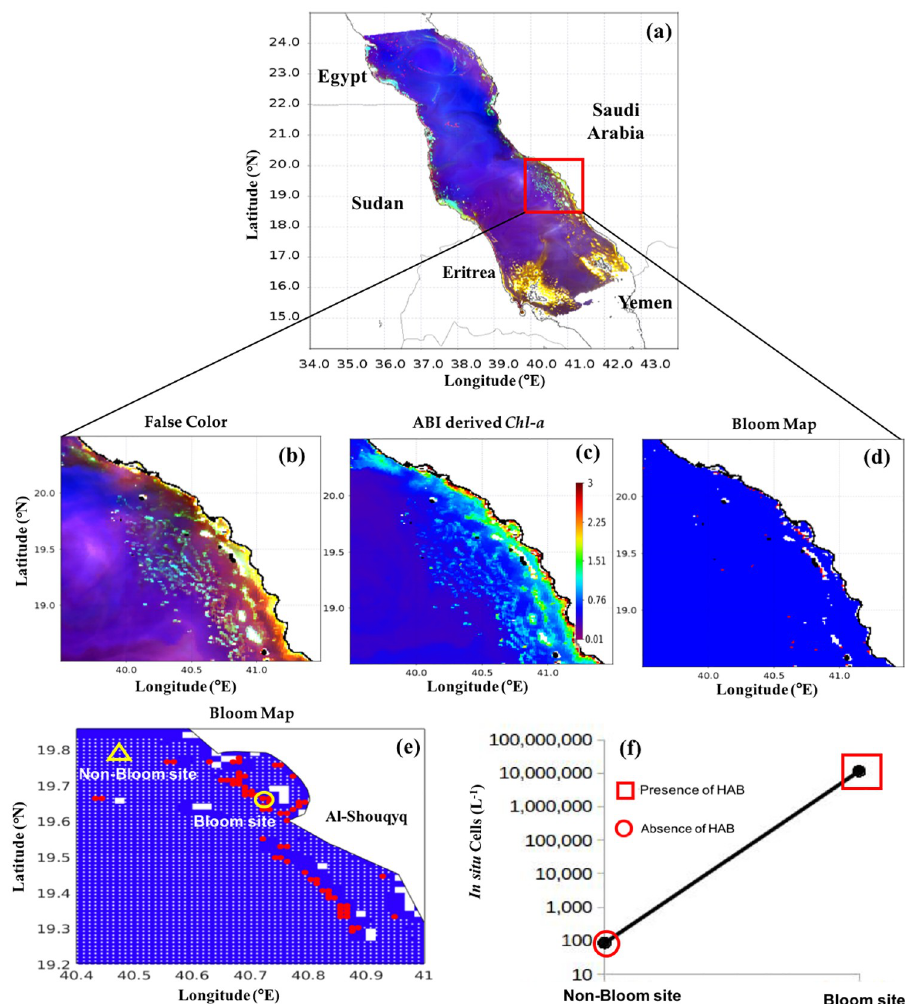
Fig 7. Remotely sensing H . akashiwo blooms in the central Red Sea and comparison with in situ measurements. (a) and (b) False color composite image generated using the NIR, green and blue reflectances (i.e., R = R R rs (547), B = R rs (443)). (c) Satellite-derived Chl-a using ABI algorithm. (d) and (e) MODIS-Aqua-derived maps of the H . akashiwo blooms in the Red Sea on 27 th May 2010 [In (e) the red and white dots denote the presence and absence of HABs, respectively, as detected using satellite data. Also, the yellow circle and yellow triangle indicates the in situ sample points and highlight the presence and absence of H . akashiwo blooms, respectively]. (f) Variations in H . akashiwo cell counts recorded from the two different sampling sites in the Red Sea off the southern coast of Saudi Arabia on 27 th May 2010 [red square and red circle denotes the satellite detection of HAB presence and absence,